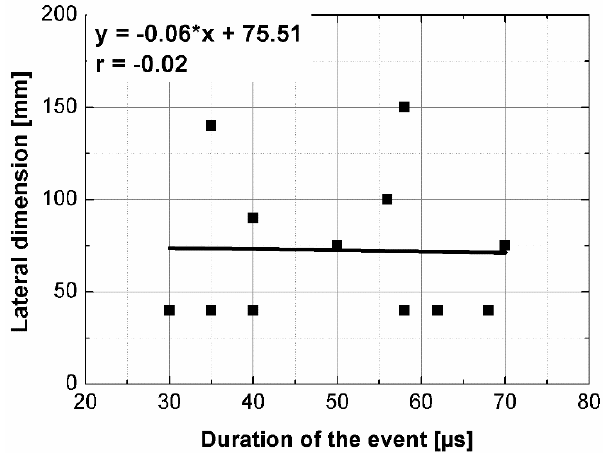
Figure 19. The duration of the main event plotted against minimal lateral dimension.